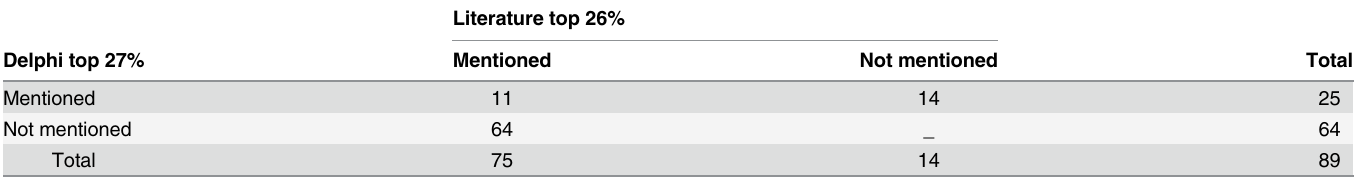
Table 3. Comparison of factors mentioned in the Delphi top 27% and the literature top 26%.